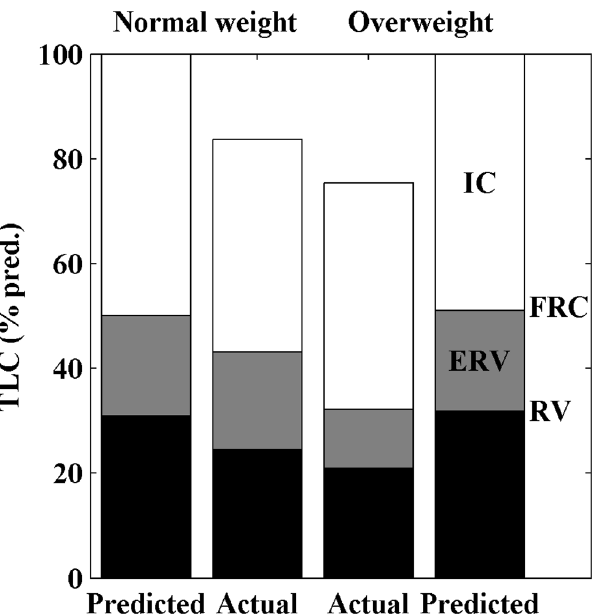
Fig 2. Stacked-bar histogram of total lung capacity (TLC) (% of predicted) in patients with normal weight (body mass index [BMI] < 25 kg/m 2 , n = 43) and overweight (BMI (cid:1) 25 kg/m 2 , n = 62), compared with their predicted values. The black section of the stacked-bar indicates the residual volume (RV), the gray section the expiratory reserve volume (ERV) and the white section the inspiratory capacity (IC). The RV and ERV combined (black plus grey) is the functional reserve capacity (FRC). A restrictive pattern of pulmonary function is shown for both groups, and the TLC is further decreased in overweight compared with normal-weight patients, mainly due to the decreased